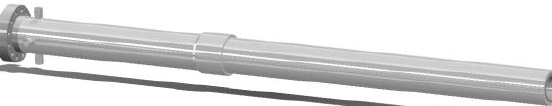
Fig. 3. Conceptual design of equatorial ECH launcher waveguide for ITER.